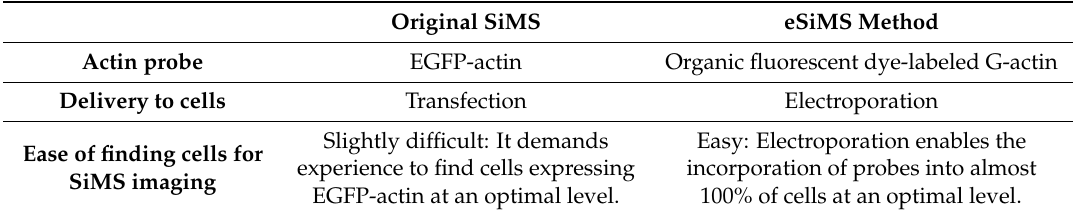
Table 1. Comparison between the original SiMS method [19] and the eSiMS method [33]. Original SiMS eSiMS Method Actin probe EGFP-actin Organic fluorescent dye-labeled G-actin Delivery to cells Transfection Electroporation Slightly difficult: It demands Easy: Electroporation enables the Ease of finding cells for experience to find cells expressing incorporation of probes into almost SiMS imaging EGFP-actin at an optimal level. 100% of cells at an optimal